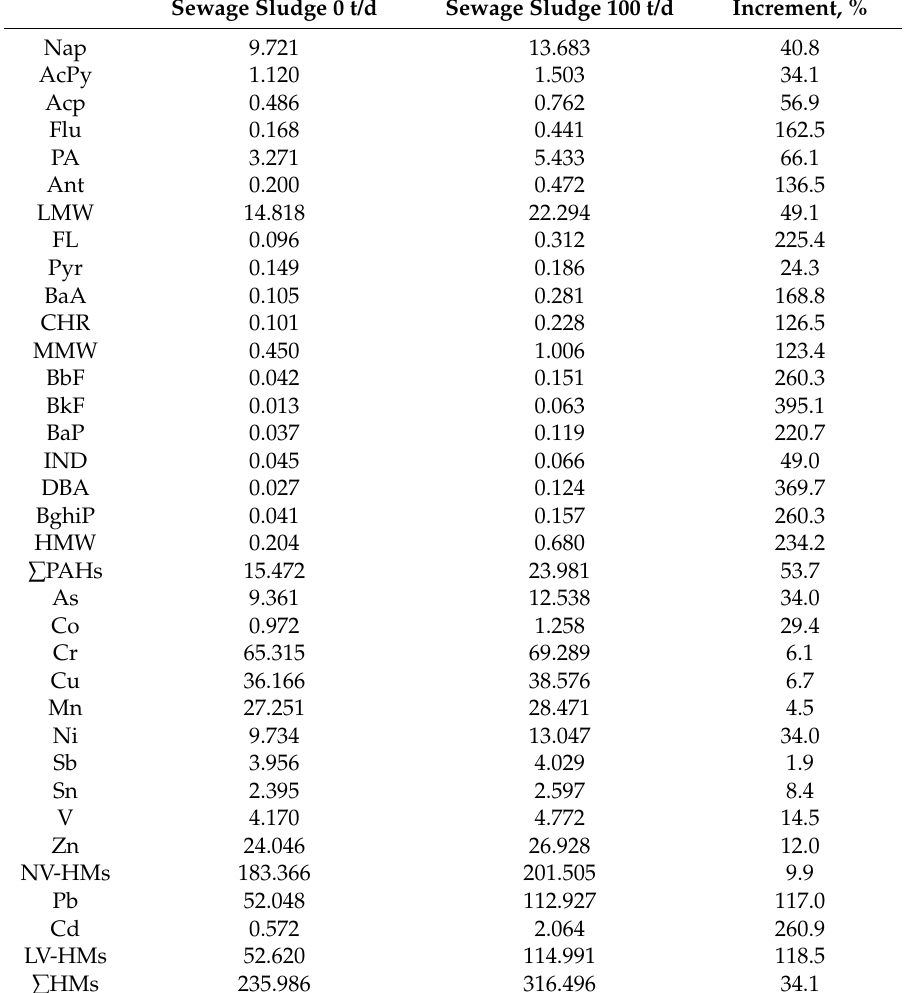
Table 2. Polycyclic aromatic hydrocarbons and heavy metals concentrations ( µ g/Nm 3 ) in the flue